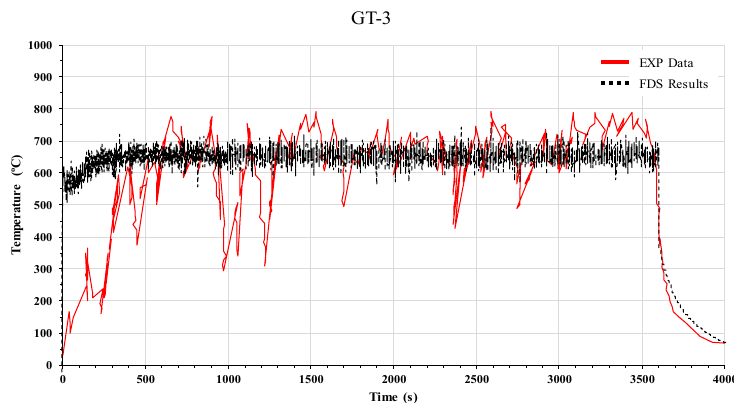
Figure 15. Gas cloud temperature over time at GT-3.